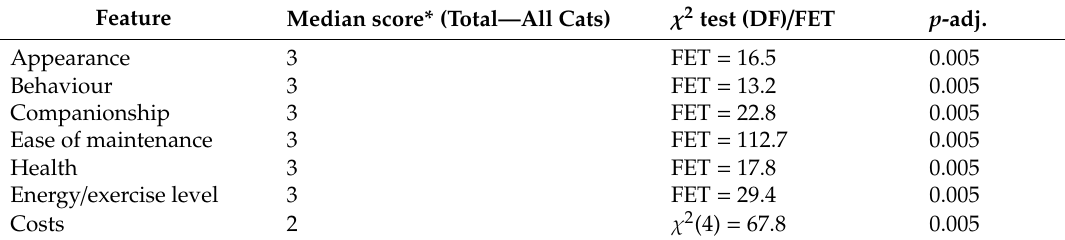
Table 4. (a) Analysis of owners’ perceptions of cat features. (b) Owners’ perceptions of cat features by cat